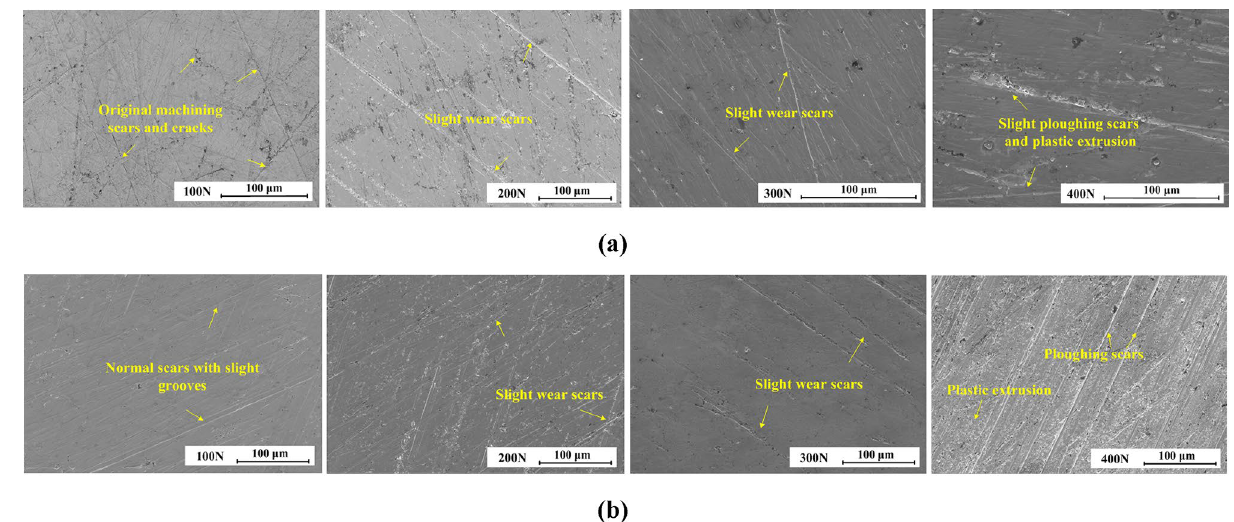
Figure 8. Wear topographies of bottom specimens versus the textured upper specimens: ( a ) under rich-oil lubrication condition; ( b ) under poor-oil lubrication